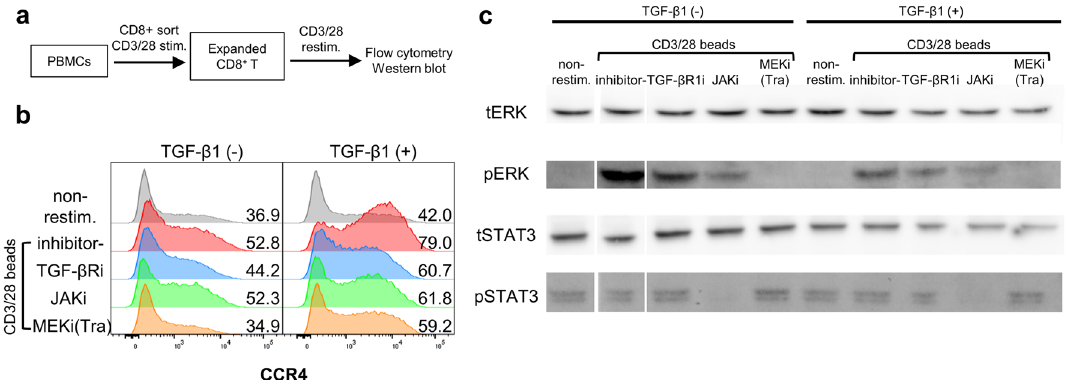
Figure 3. ERK in CD8 + T-cells was phosphorylated by CD3/28 stimulation and inhibited by trametinib. Pre- expanded CD8 + T-cells from HD6 were supplemented with 100 IU/mL IL-2, with or without 10 ng/mL TGF-β1, and a kinase inhibitor for 3 h. CD8 + T-cells were restimulated with CD3/28 beads. Experimental methods are shown in ( a ). CCR4 expression was evaluated using flow cytometry on day 2 ( b ). The same samples as in ( b ) were collected 10 min after stimulation, and phosphorylation of ERK and STAT3 was evaluated by western blotting ( c ). In the image in ( c ), the left-most and second left-most lanes are transposed. Original images are shown in Supplementary Fig. S7. t total, p